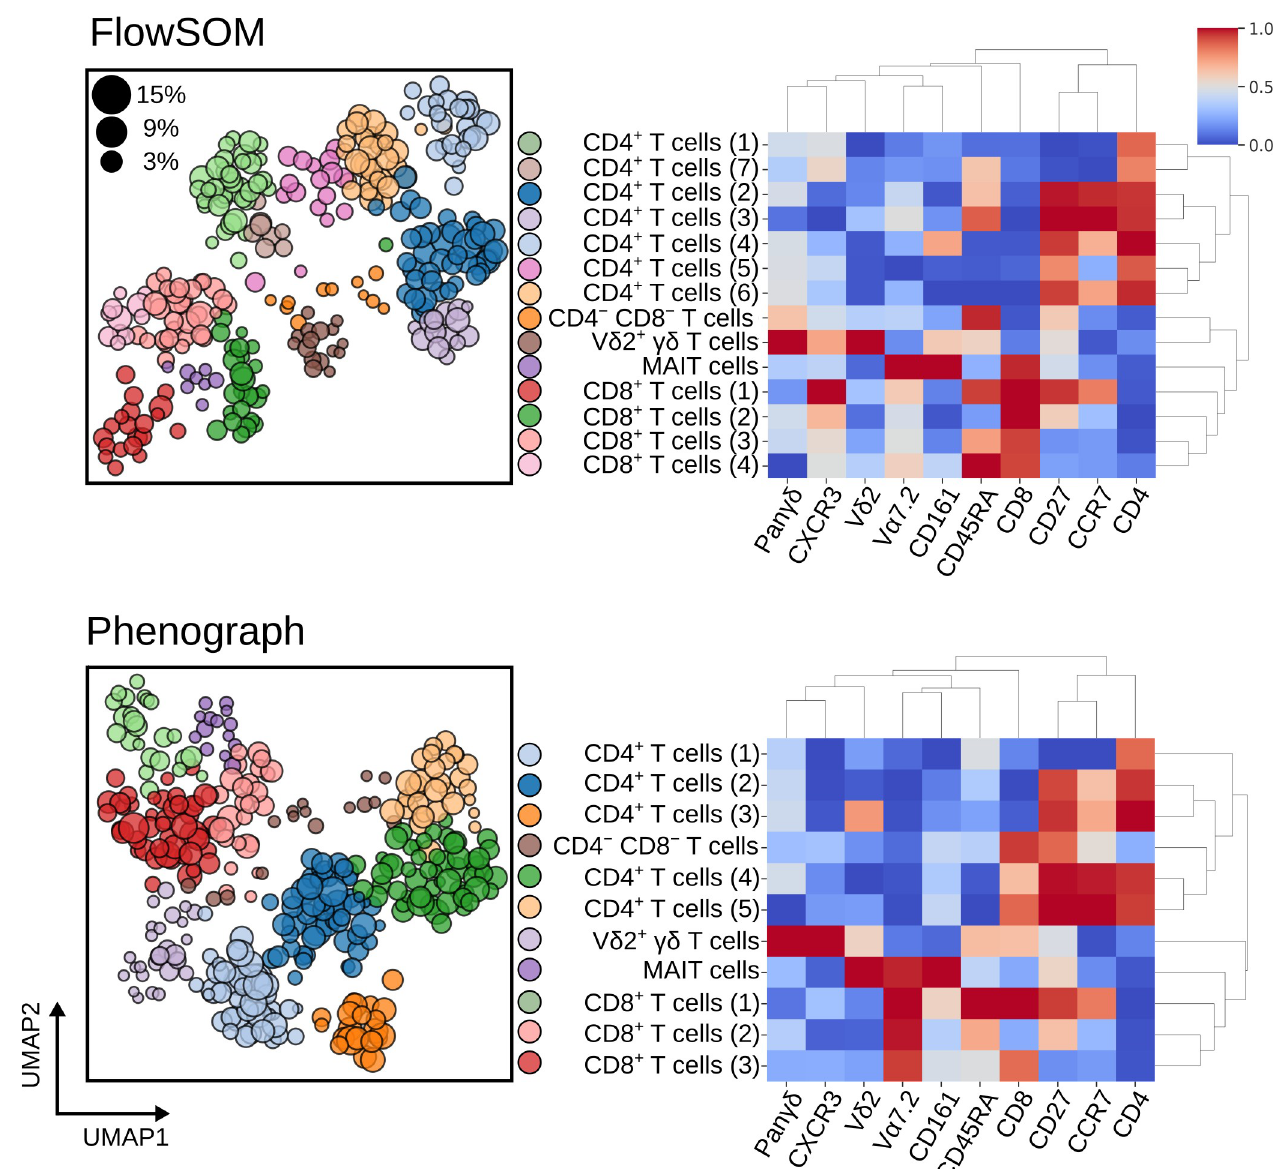
Fig 6. Meta-clustering results for FlowSOM (top) and Phenograph (bottom) when applied to blood T cells after batch effect correction with Harmony. Heatmaps show the normalised expression of cell surface markers for meta-clusters (clustered centroids of individually clustered patient samples). In the neighbouring UMAP plots, clusters from all patients are shown in the same embedded space and coloured by their meta-cluster membership. The size of each data point corresponds to the percentage of T cells this cluster represents in the patient it was derived